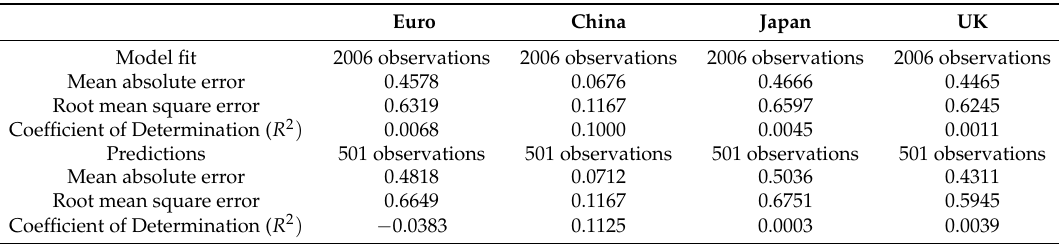
Table 9. Neural network regression error